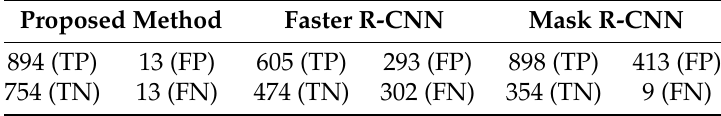
Table 3. confusion matrices of three methods.